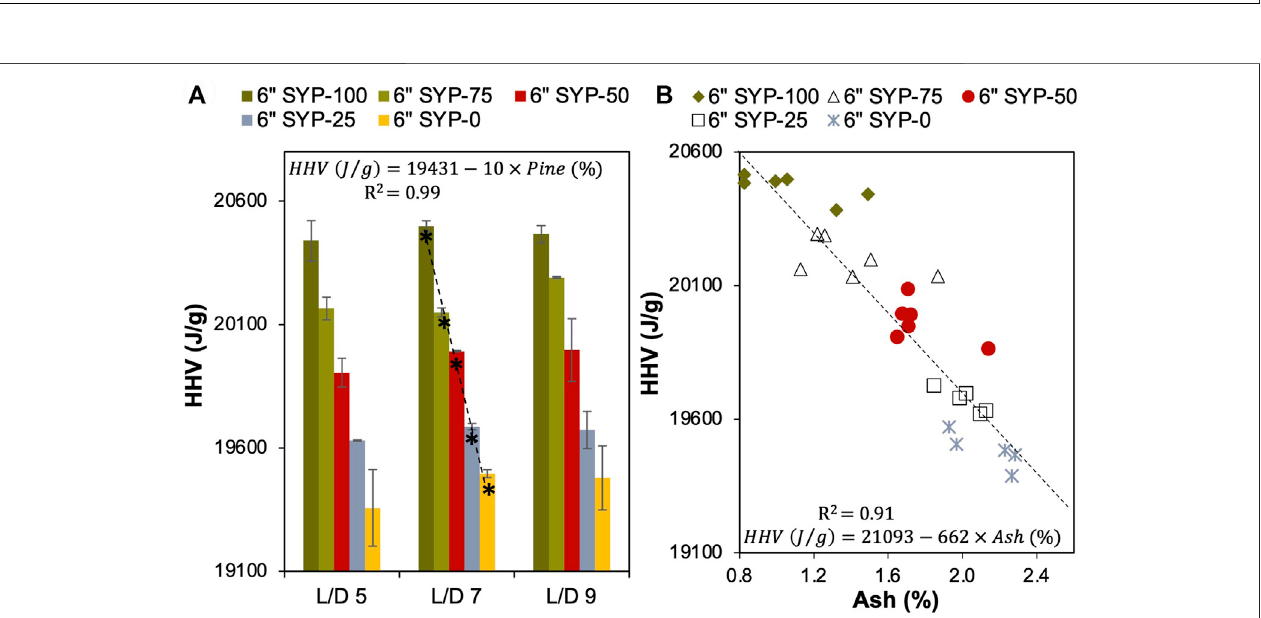
FIGURE3 |(A) Variations in thehigher heatingvalue(HHV)of pellets asafunction ofbiomass blendand length-to-diameter(L/D) ratios. The dotted linerepresents linear regression between pellet pine content (%) and HHV (J/g) for all L/D ratios, while the corresponding regression equation is provided as an inset; (B) Distribution of pelletHHVasafunctionofashcontent.Southernyellowpine(SYP)topsof6-in.(152.4 mm)stemdiameterweregroundinahammermill fi ttedwith6.35 mmscreenand was blended with similarly ground switchgrass (SG) at 100:0 (SYP-100), 75:25 (SYP-75), 50:50 (SYP-50), 25:75 (SYP-25), and 0:100 (SYP-0) ratios. The linear regression of pellet HHV and ash content is represented as a dotted line, with the corresponding equation provided as an inset.